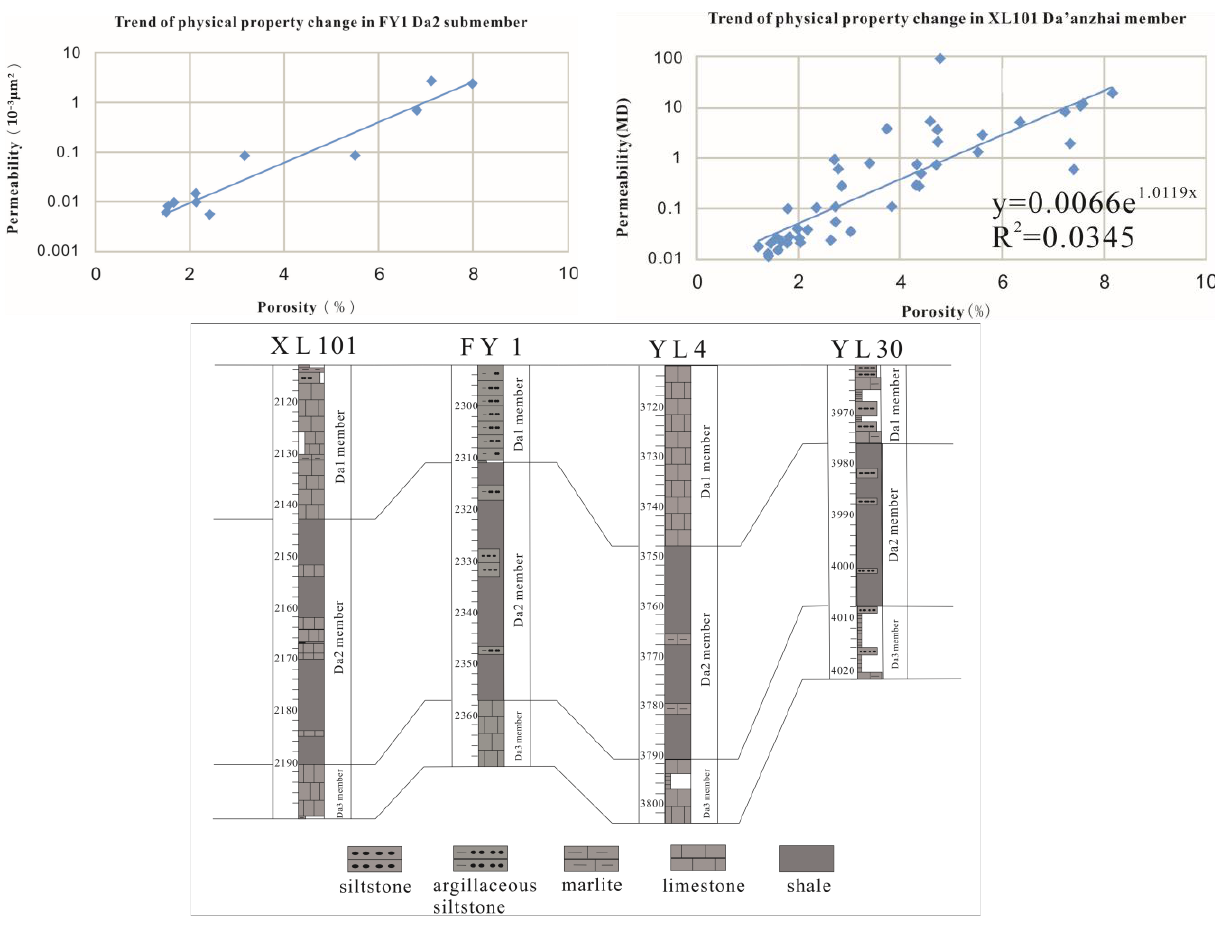
Figure 7. The cross section and trend of physical properties of Da’anzhai shale in the Fuling area.